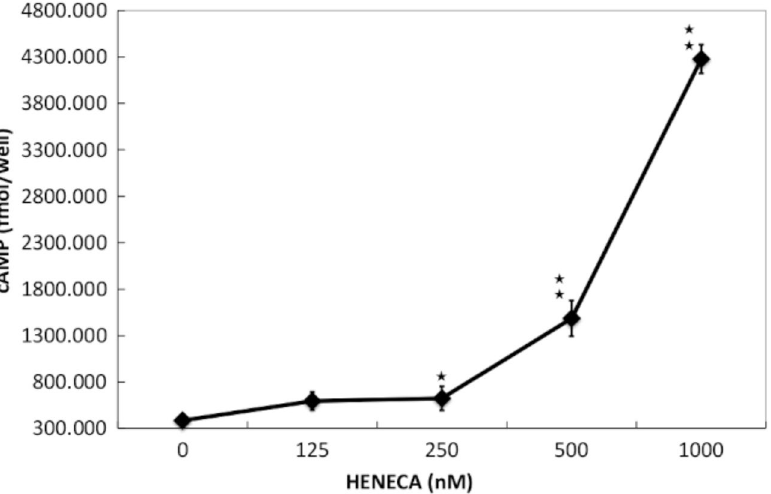
Figure 2. Detection of functional A 2A AdoR expression in MH7A cells. Adenosine A 2A receptors in MH7A cells are functionally coupled to adenylyl cyclase and intracellular cAMP production. Cells were stimulated for 30 min with the indicated concentration of A 2A AdoR agonist HENECA. Experiments were repeated three times, and data are presented as the mean ± SD. ★ p < 0.01 versus 0 μM HENECA. Intracellular cAMP levels were measured using an enzyme immunoassay.